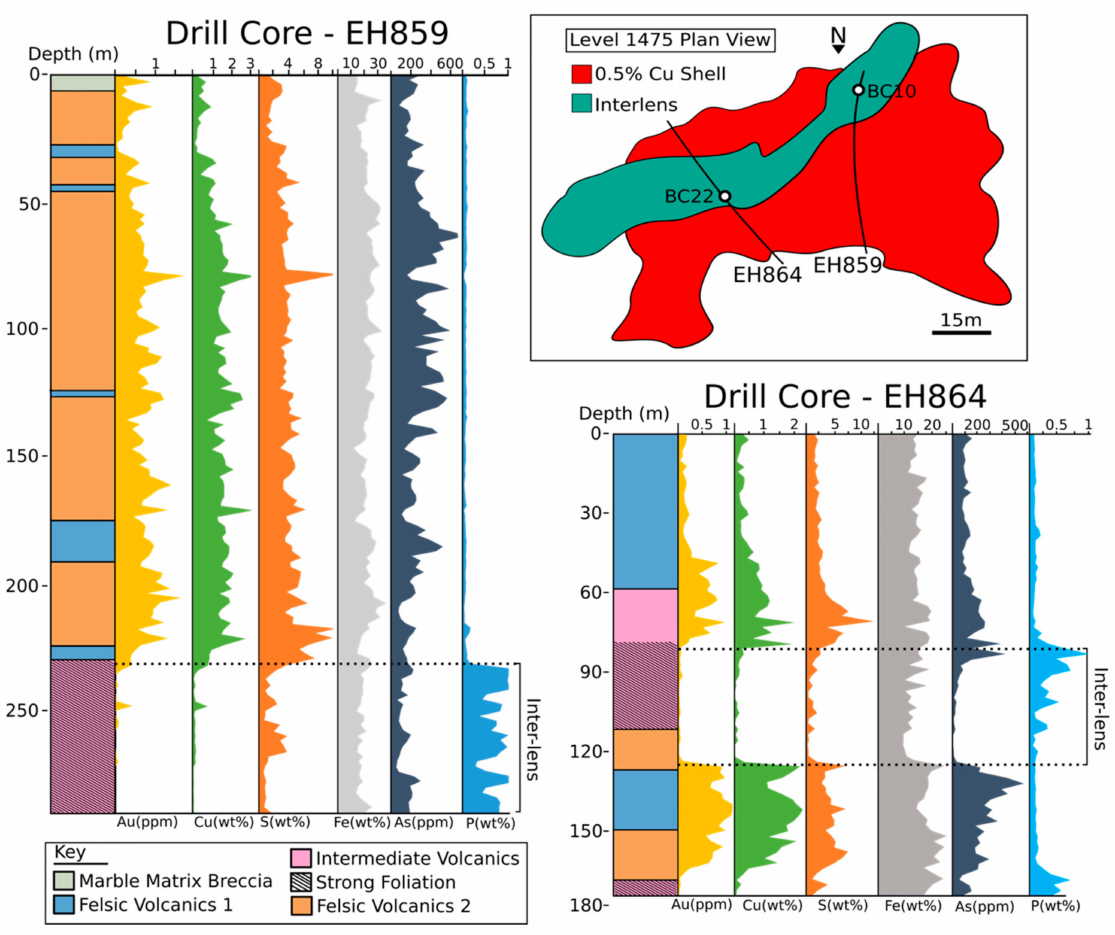
Figure 3. The lithology and assay data of Cu, Au, S, As, and P from drill core EH859 and EH864. As the Inter-lens is intersected, there is a large increase in P, no significant change in Fe, and a decrease in Cu, Au, S, and As concentrations. A map of the drill core locations is provided, displaying the location of samples BC10 and BC22 used for U–Pb geochronology and trace element